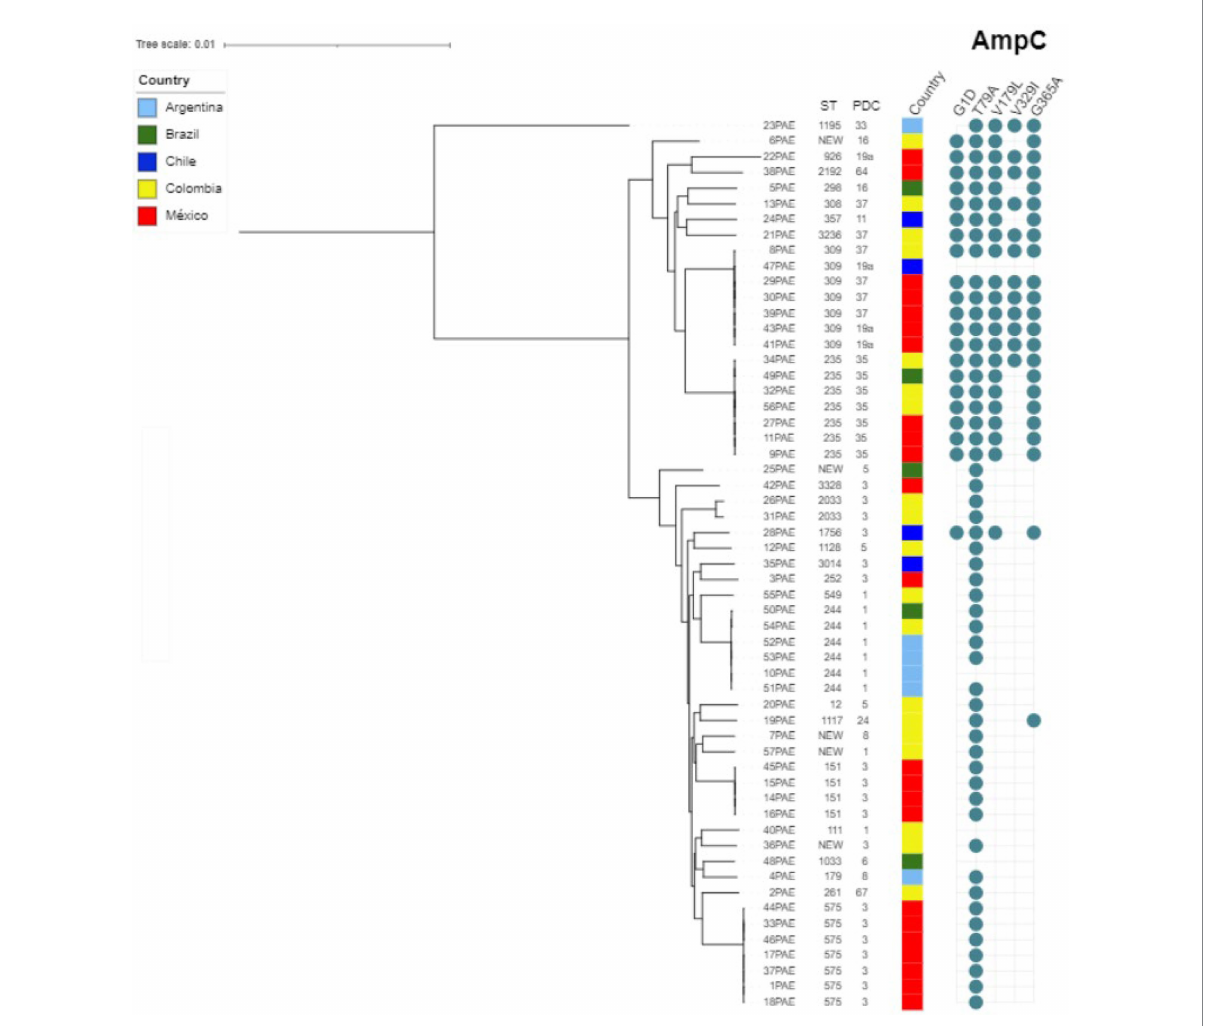
FIGURE 3 Genetic relatedness among TOL non-susceptible Pseudomonas aeruginosa isolates. The phylogenetic tree was obtained by RAxML from the core genome (ortholog genes present in more than 95% of included genomes) and drawn using the iTOL tool (Letunic and Bork,